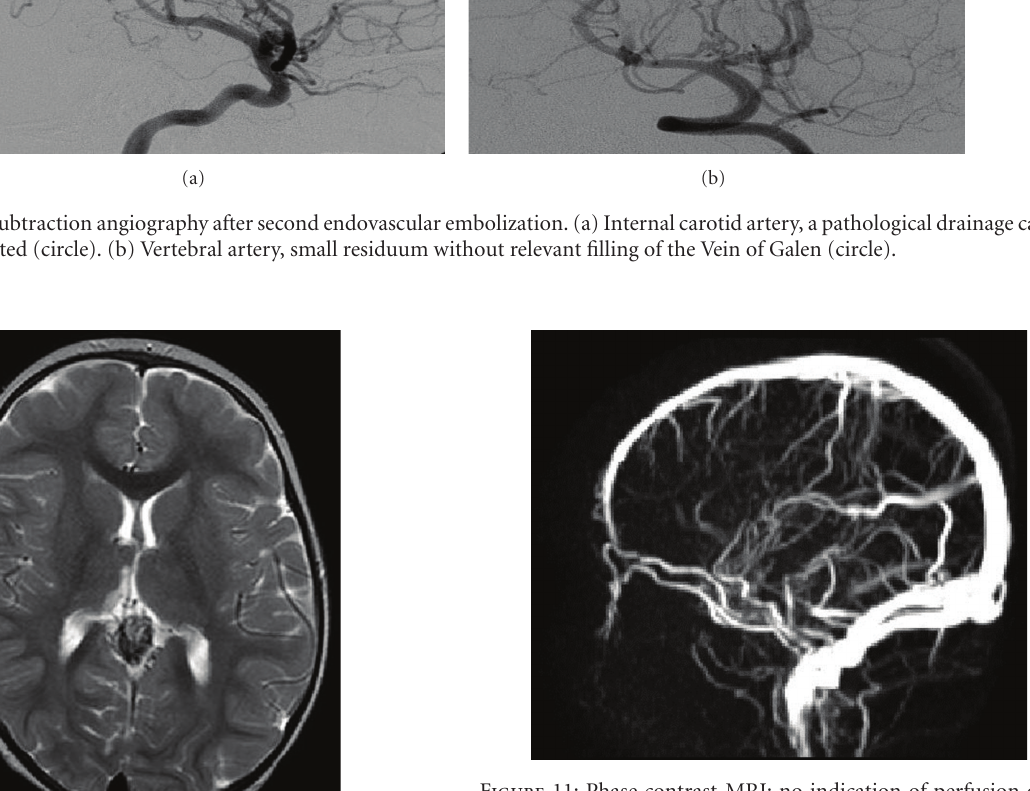
Figure 11: Phase contrast-MRI: no indication of perfusion of the venous